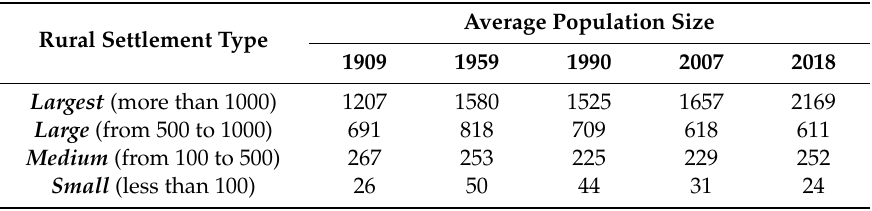
Table 5. Changes in the average population size of rural settlements within the current boundaries of the Mogilev district from 1909 to